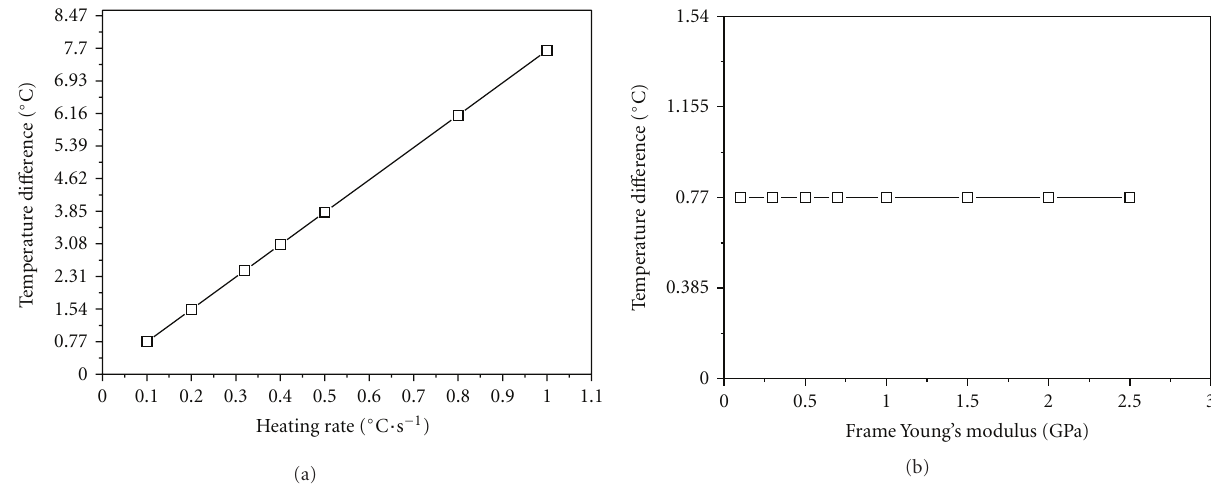
Figure 2: The temperature di ff erence between the superior surface and bottom surface of the ceramic plate versus (a) the rate of slow heating (the frame Young’s modulus 1GPa) and (b) the frame Young’s modulus (slow heating rate 0.1 ◦ C · s − 1 ).